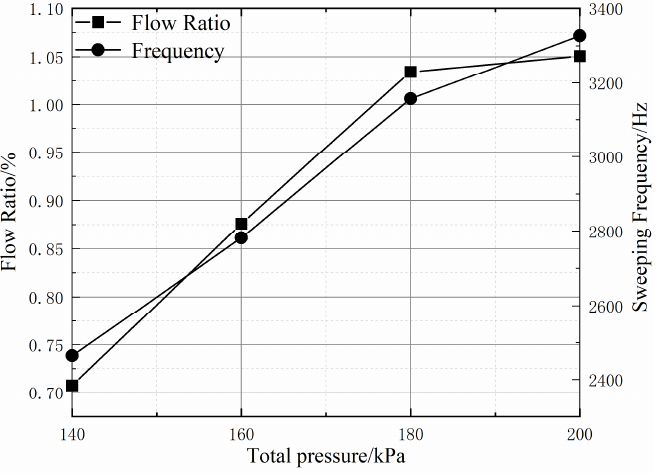
Figure 12. Sweep frequency and flow ratio at various total